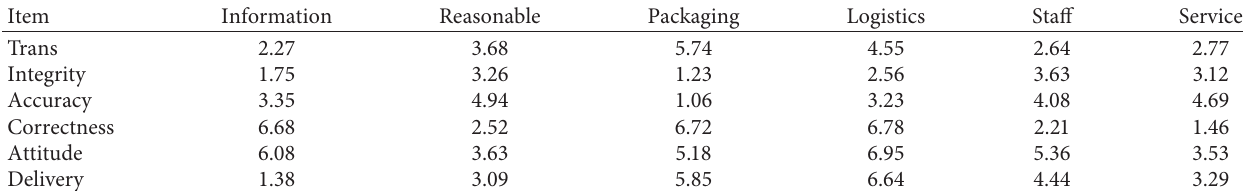
Table 7: Delivery staff’s service attitude and delivery speed.